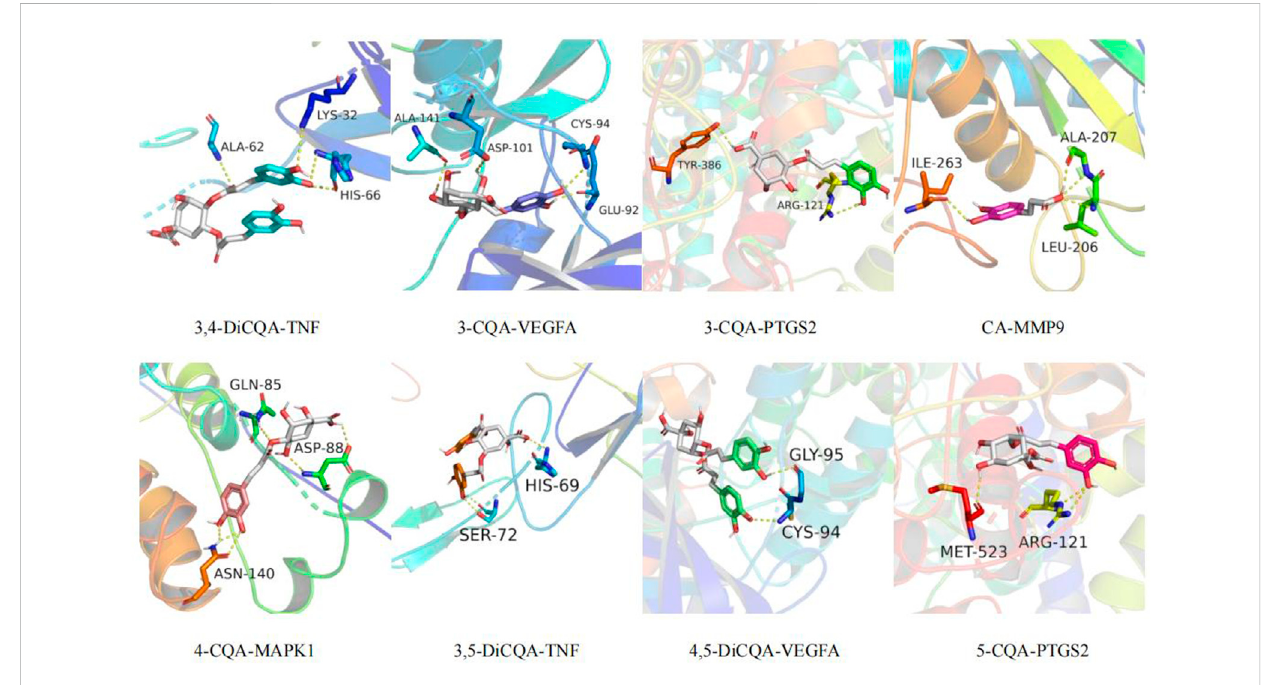
FIGURE 10 Docking mode of the 7 phenolic acids with their key